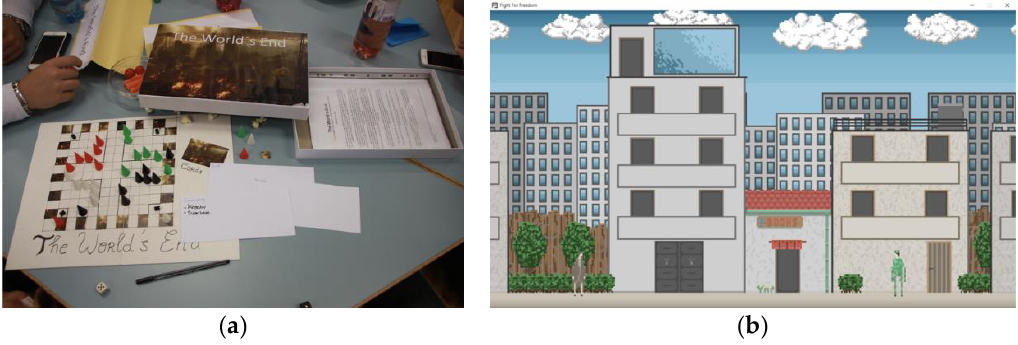
Figure 2. Student-created games from the Sparkling Games project. ( a ) The World’s End is a tactical board game for two players, where they try to breach each other’s firewall; ( b ) in the digital point-and-click adventure game Fight for Freedom players mostly work out how to orient themselves in a future society where analogue and printed media have ceased to